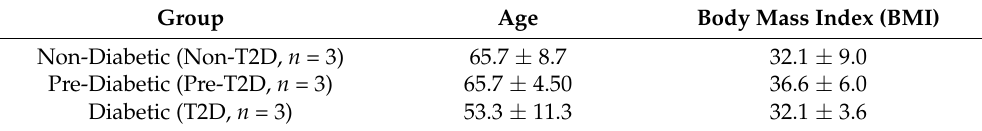
Table 1. Information on IPFP Donors. Group Non-Diabetic (Non-T2D, n =